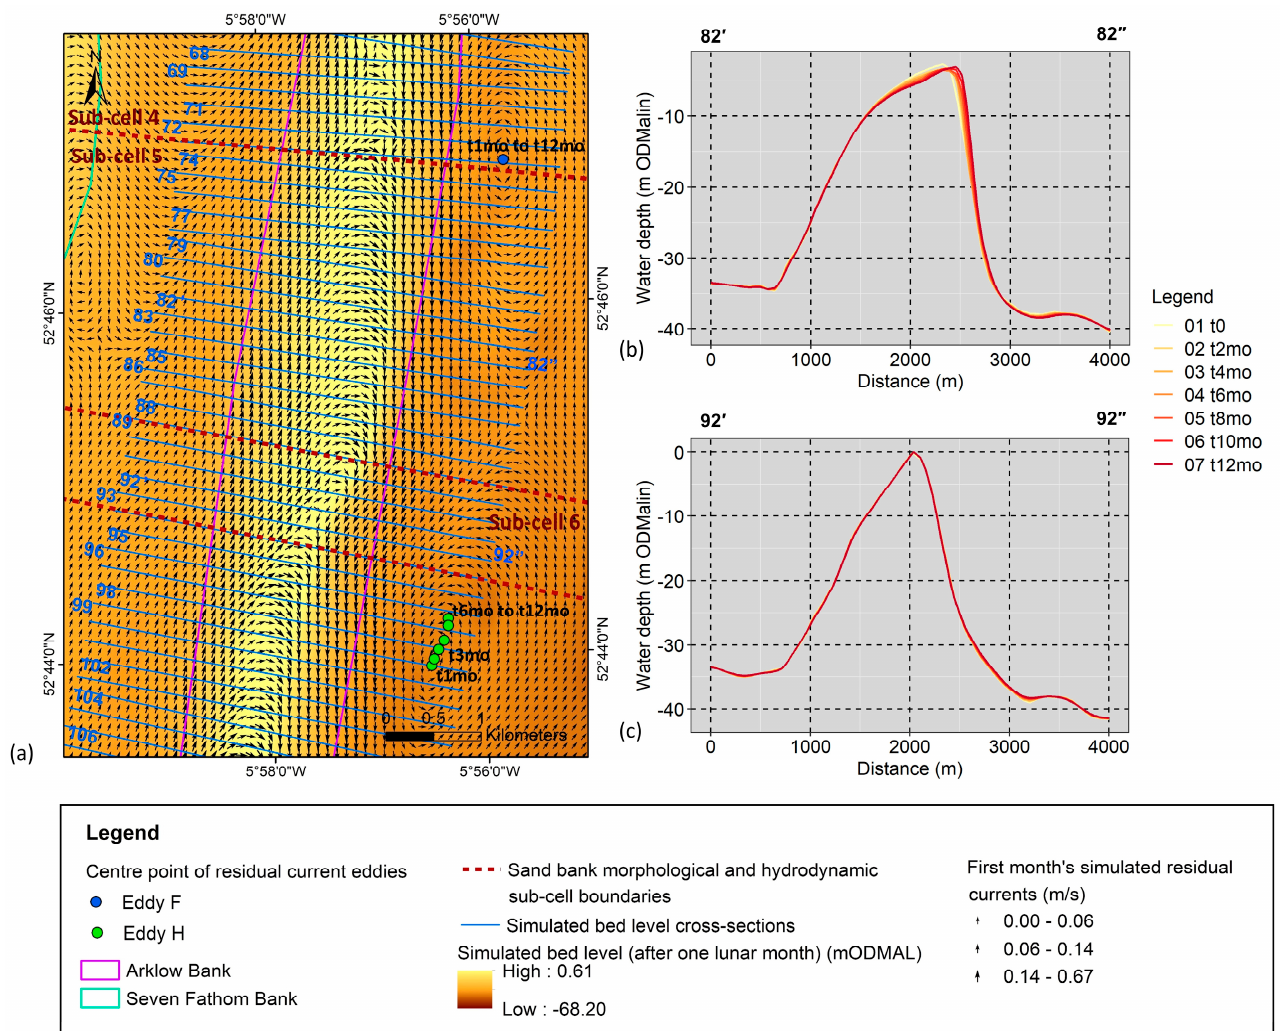
Figure 10. Morphodynamics and hydrodynamics at Sub-cells 5 and 6 of Arklow Bank. ( a ) Simulated bed level change after one lunar month and associated residual current vectors, overlain by the location of the centre point of residual eddies from residual currents during each subsequent lunar month simulation; ‘t6mo’ is the sixth lunar simulation month. ( b , c ) Simulated bed level over a one year simulation at cross-sections 82 and 92; ‘t0’ is the starting bed level, and ‘mo’ is subsequent months.